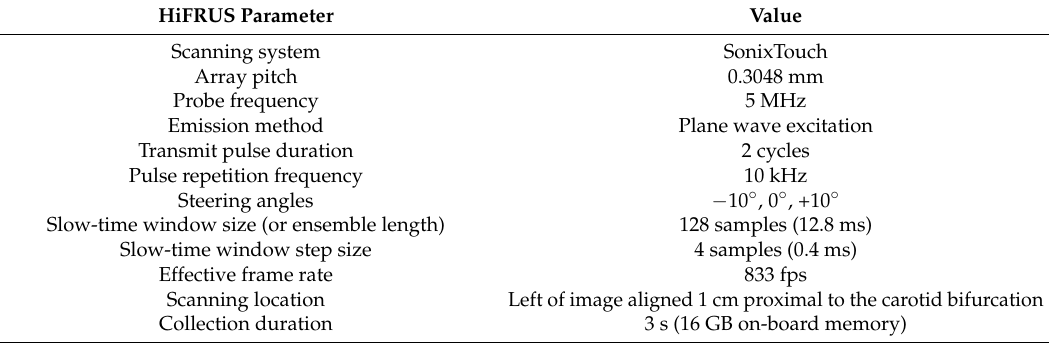
Table 1. Technical reporting in high frame rate ultrasound (HiFRUS) investigations and proposed details for the research example presented in Section